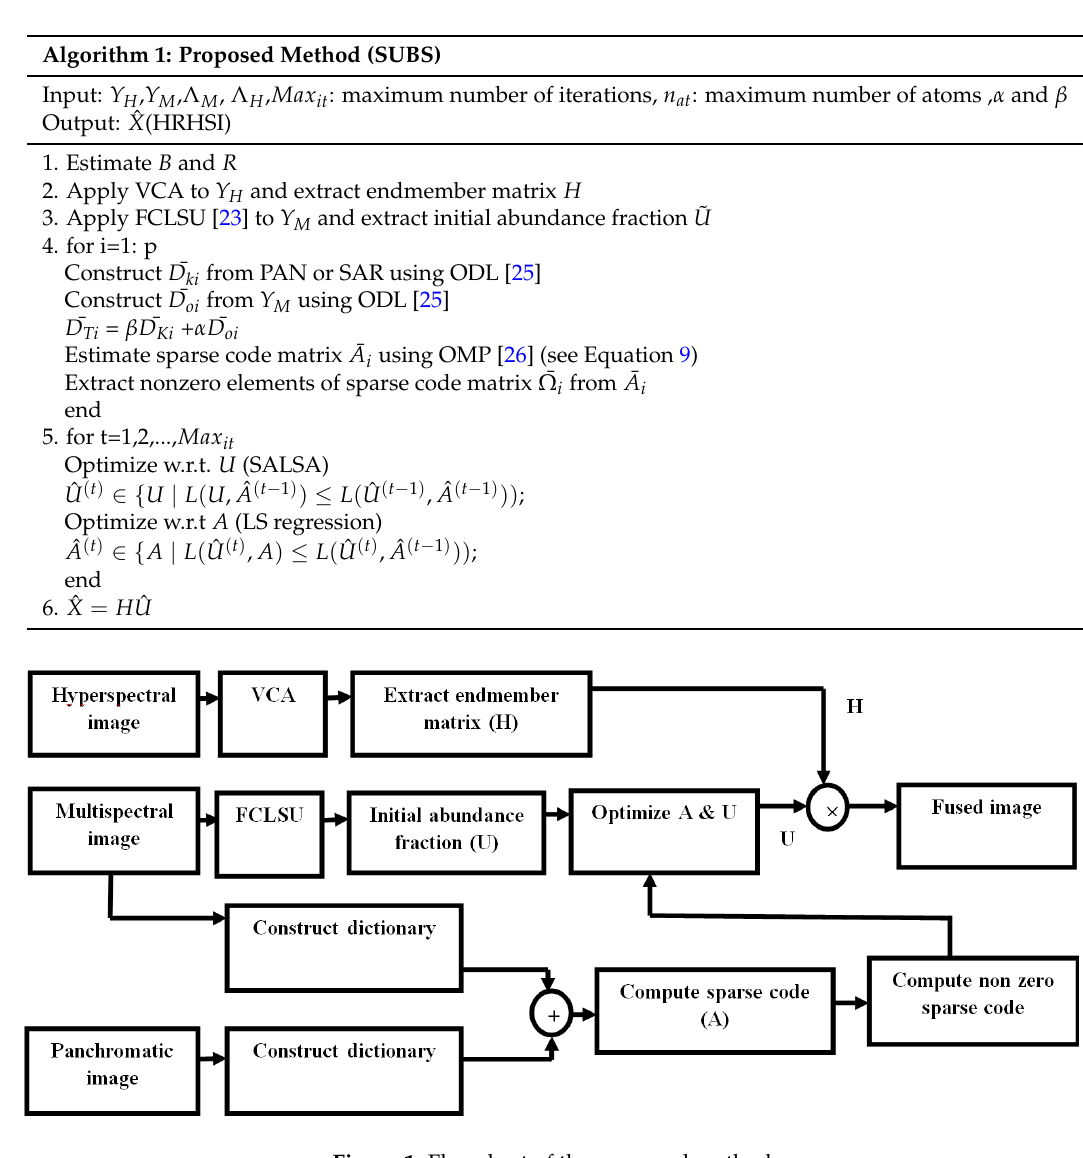
Figure 1. Flowchart of the proposed